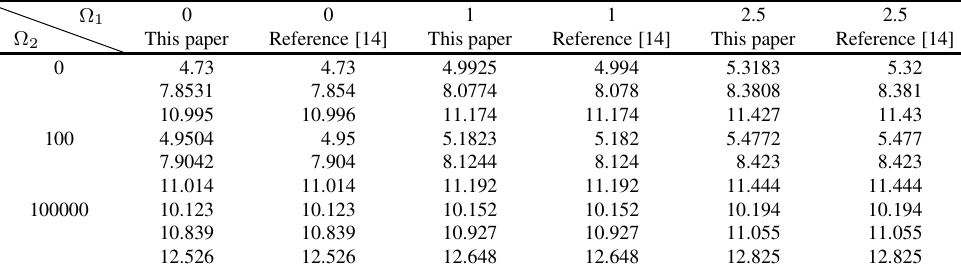
Table 6 Numerical comparisons with reference [14] for a clamped-clamped beam on Pasternak